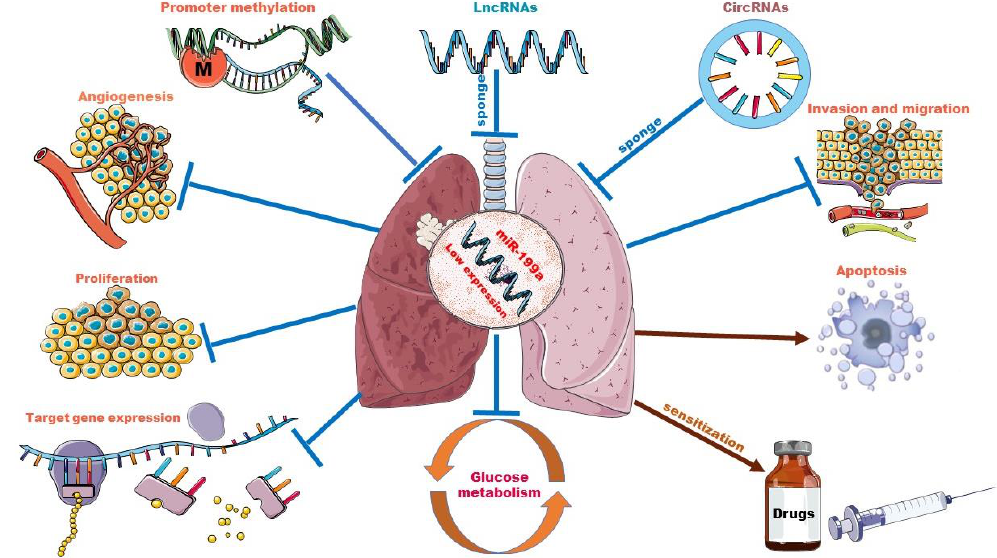
Figure 2. The role of miR-199a in lung cancer and interplay with other ncRNAs. Promoter methylation and sponge adsorption of lncRNAs and circRNAs resulted in low expression levels of miR-199a. miR-199a acts as a tumor suppressor in lung cancer by targeting downstream genes. Overexpression of miR-199a could inhibit lung cancer cell proliferation, infiltration and migration, glycolytic pathway and tumor angiogenesis and increase lung cancer cell apoptosis. In some drug-resistant lung tumor cell lines, it also plays a sensitizing role.